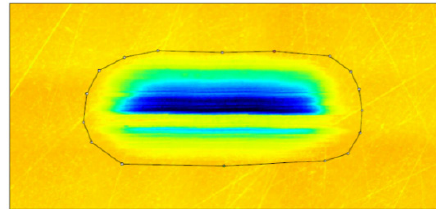
Figure 4. Confocal microscopic image of the worn surface on the disc specimen with 0.5 wt% CuO-dosed